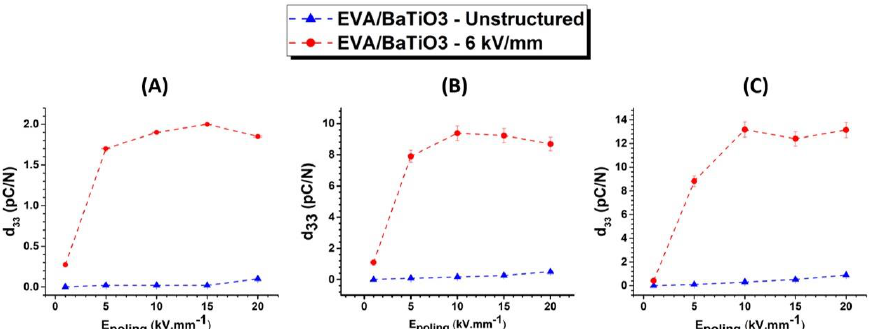
Figure 11. Piezoelectric charge coefficient versus poling electric field of 0 – 3 EVA/BaTiO 3 and 1 – 3 EVA/BaTiO 3 with a volume fraction of ( A ) 3 vol%, ( B ) 16 vol%, ( C ) 29